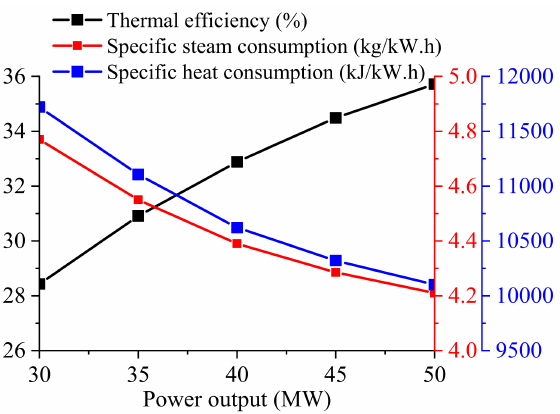
Figure 9. Effect of power output on the operating performance of the power